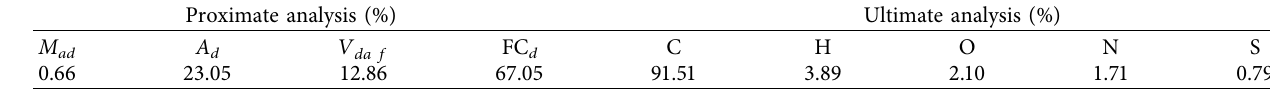
Table 1: Proximate and ultimate analysis of Jincheng anthracite.